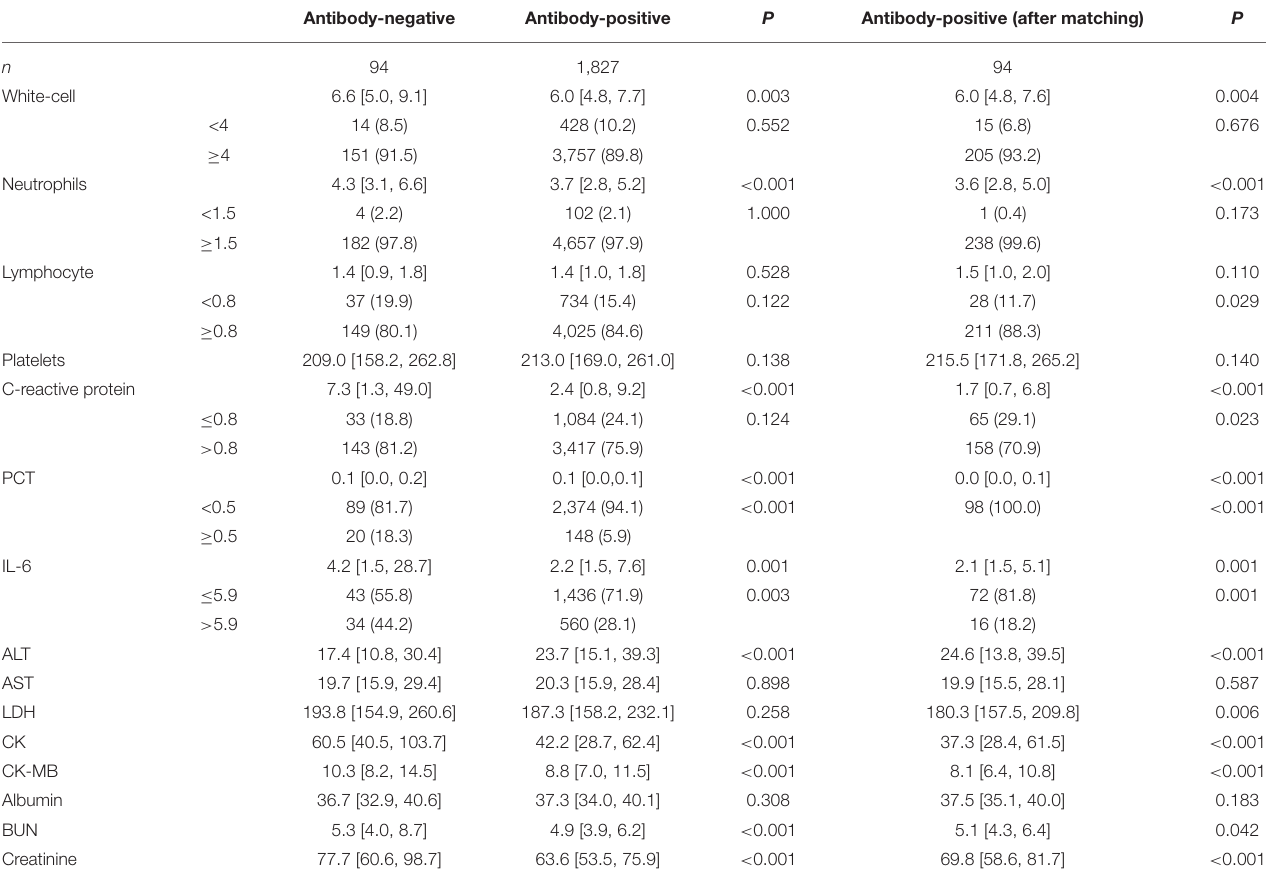
TABLE 2 | Laboratory findings on the admission of patients with COVID-19. Antibody-negative Antibody-positive P Antibody-positive (after matching) P 94 1,827